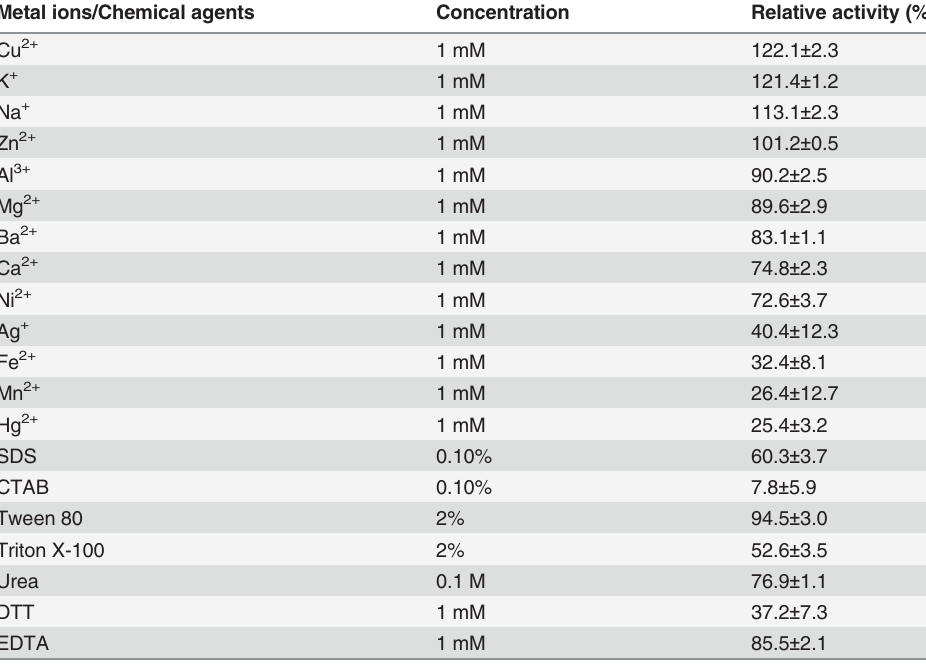
Table 2. Effect of various metal ions and chemical agents on enzyme activity. Metal ions/Chemical agents Concentration Relative activity (%) Cu 2+